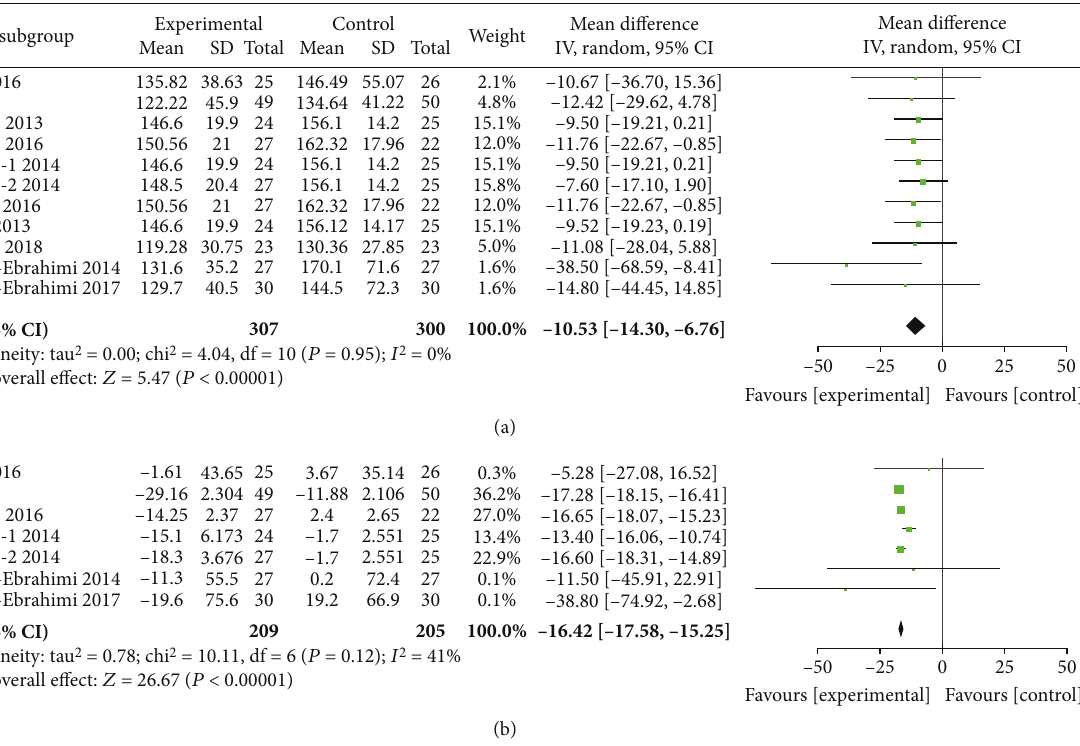
Figure 4: Findings of a meta-analysis of studies with continuation data on improvement in FPG for ITC vs. control groups, with estimated MD and 95% CI. (a) Postintervention data of FPG. (b) Reduction data of